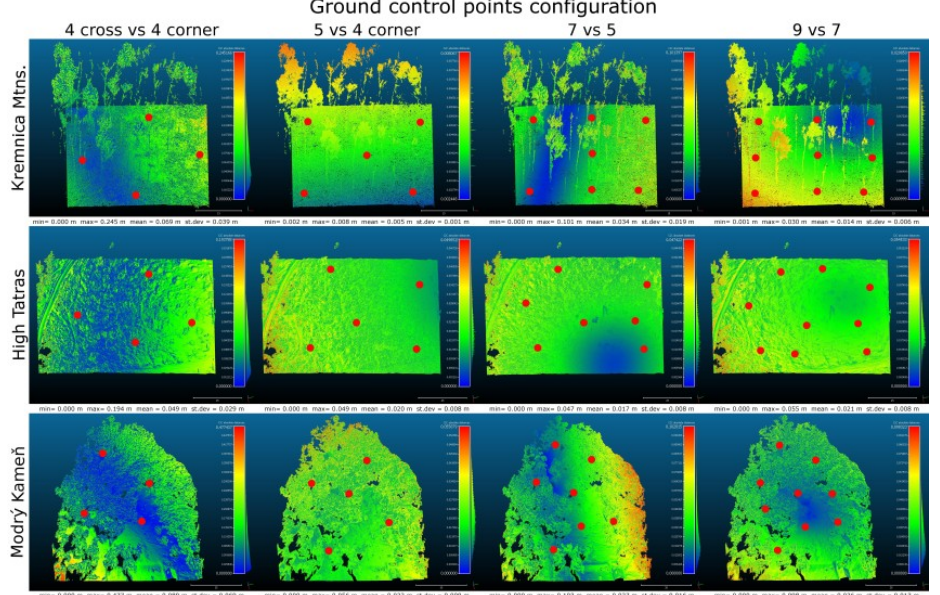
Figure 7. Cloud ‐ to ‐ cloud absolute distances between point clouds resulting from differing GCP Figure 7. Cloud-to-cloud absolute distances between point clouds resulting from differing GCP configurations according to test sites. GCPs are marked with red dots. configurations according to test sites. GCPs are marked with red